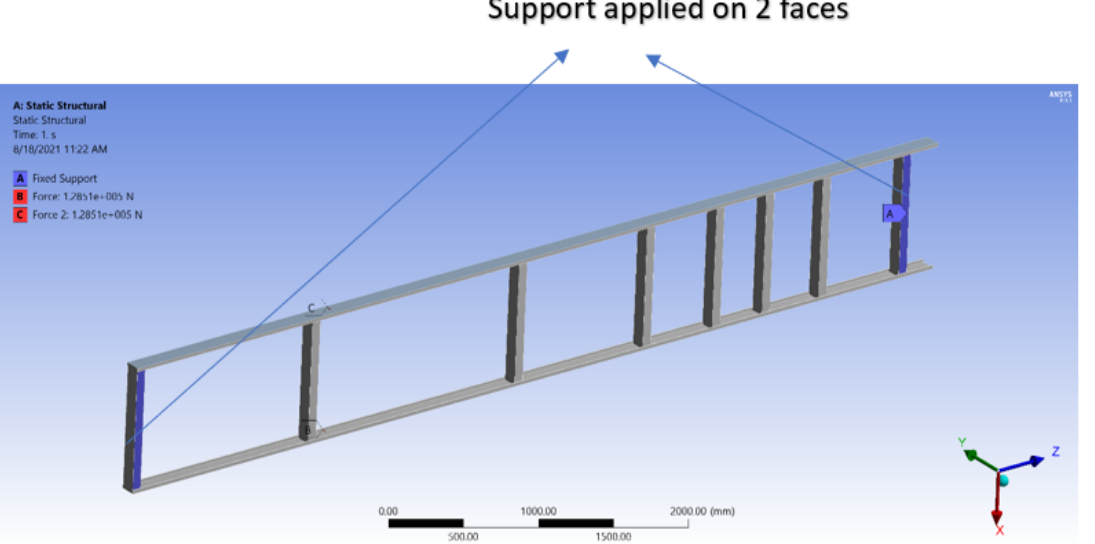
Figure 5. Loads and boundary conditions (Support Applied).